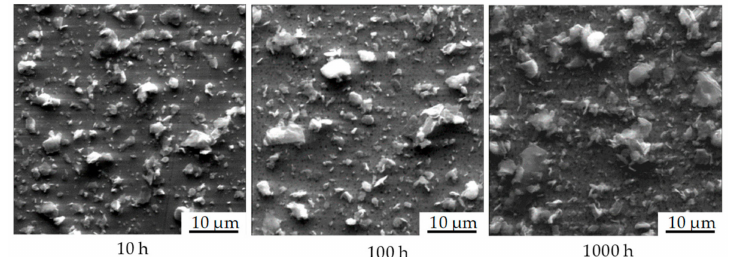
Figure 13. SEM plan-view micrographs of particle-loaded sample Inconel 617 at 750 ◦ C, 6 MPa helium, and up to 1000 h annealed